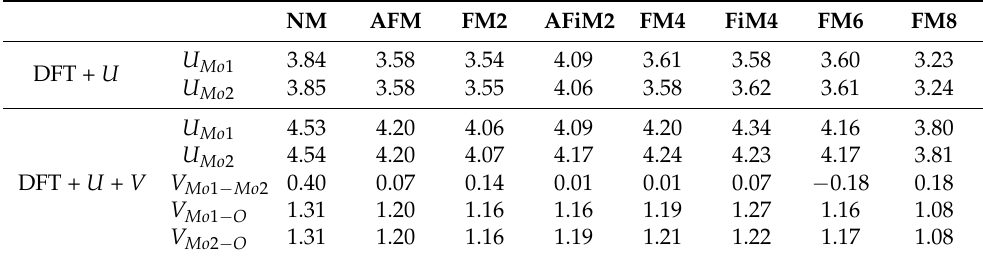
Table 2. The Hubbard parameters (in eV) computed self-consistently for various states of